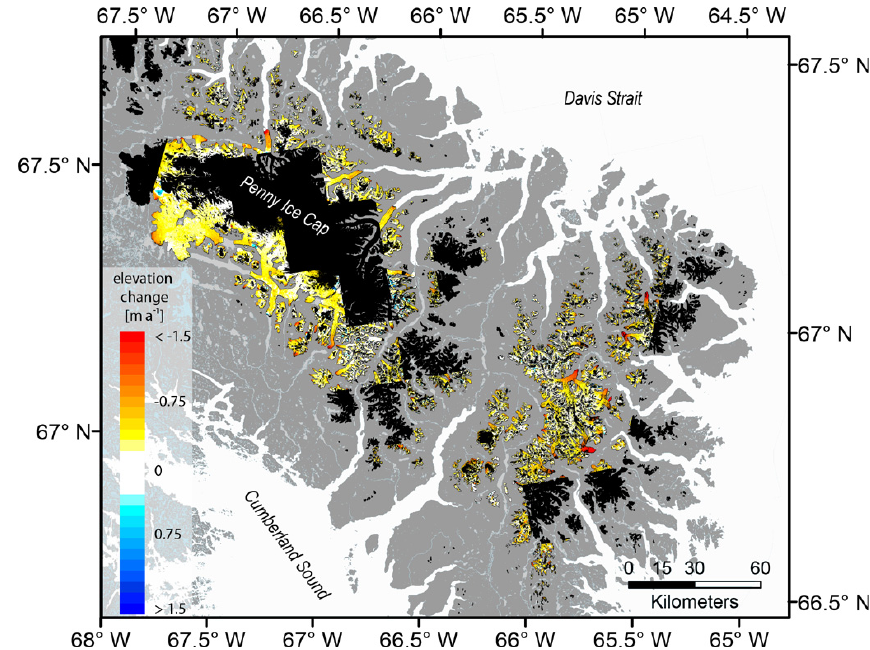
Fig. 5. Elevation change rate (ma − 1 ) of the Penny Ice Cap and the glaciers of the Cumberland Peninsula between 1958 and 2010 as determined from DEMs generated from airborne and SPOT-5 satellite stereoscopic imagery. Areas of black indicate no data.